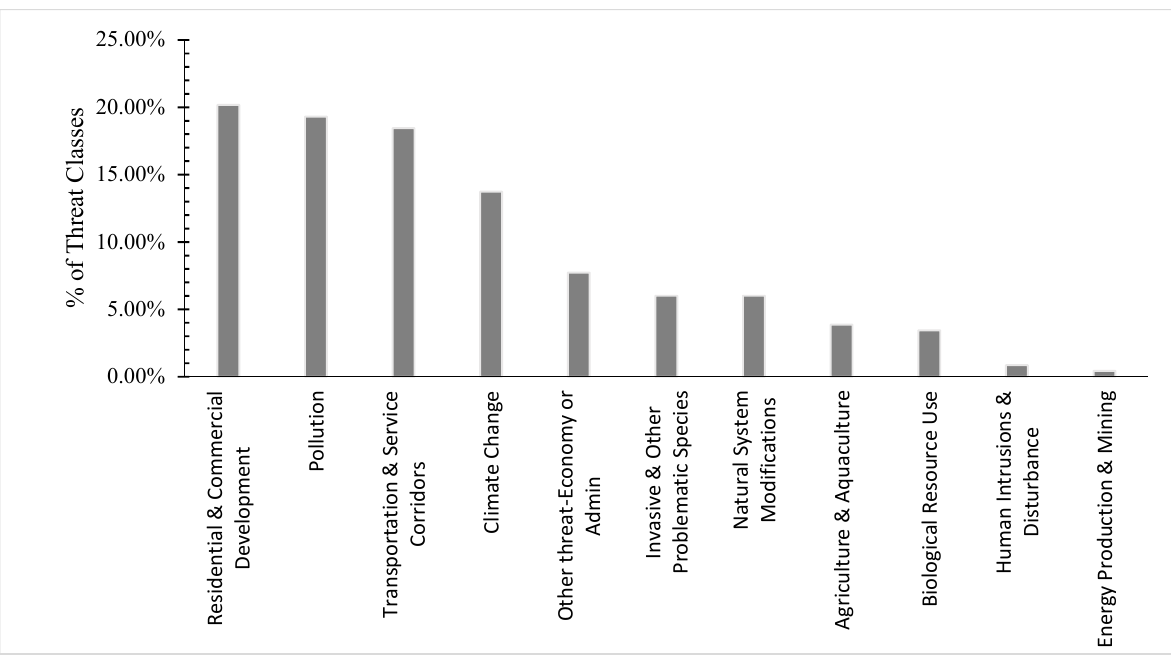
Figure 3. Frequency of direct threats identified by governmental and non-governmental stakehold- ers in the Gediz Delta based on the IUCN threat classification system (30 ind). 3.1.2. In-Depth Interviews To assess the local perspectives, a total of 30 (6 Female, 24 Male) stakeholders from 24 different socio-professional and local groups were interviewed. The stakeholders were from both governmental and non-governmental organizations (14 and 16 people, respec- tively) (Table 1). A total of 152 threats were identified in the interviews. The threats were coded using the IUCN threats classification system. A total of nine distinct threat catego- ries were identified. The most frequently cited threat in the interviews was “pollution”,